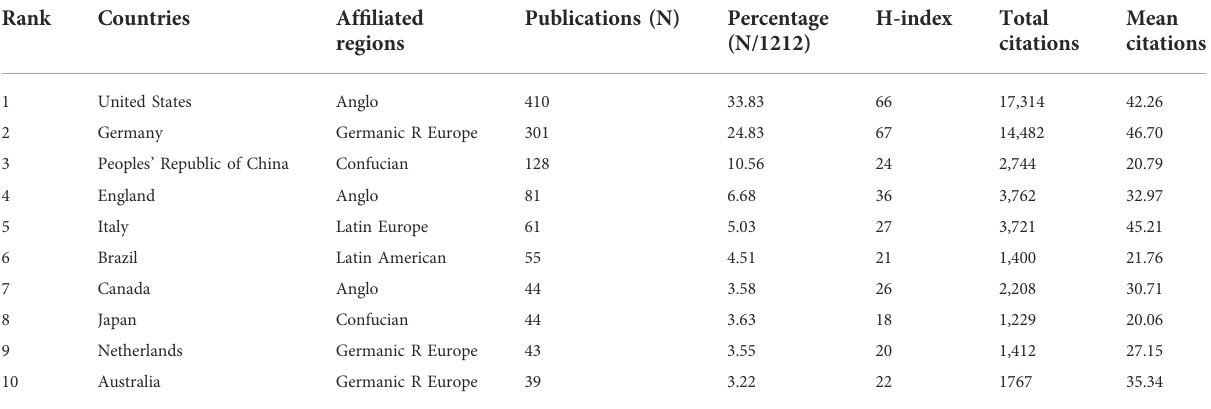
TABLE 1 The top 10 countries/regions in cardiovascular research of sGC